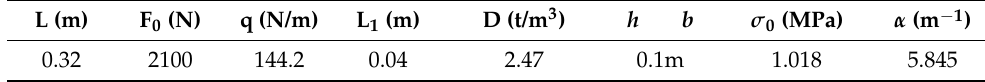
Table 6. Bending creep parameters of asphalt mixture beam